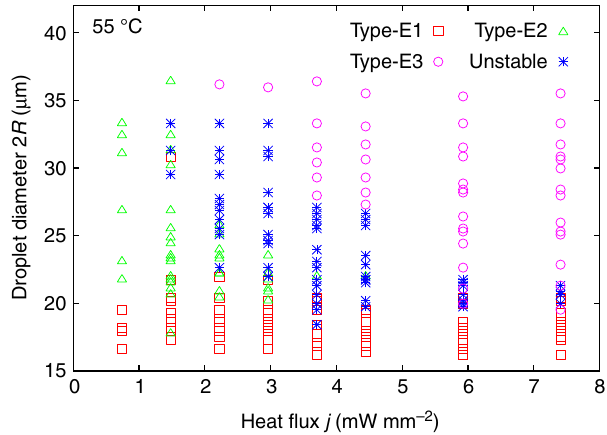
Fig. 6 State diagram of Type-E under the temperature gradient. The droplet sub-types are plotted in the plane of ( j -2 R ). The chiral content was 2.0 wt %. In the small j regions, only Type-E1 (squares) and Type-E2 (triangles) appear and show HIR without texture change (Video 4a in Supplementary Materials). However, by increasing j , Type-E2 is destabilised and transformed into Type-E3 (circles) (Supplementary Movie 8). In the region between Type-E1/E2 and Type-E3, a chaotic turbulent texture was continually observed (unstable state, CFM images for the Type-A droplet, which clearly show the radial director distribution of Type-A (Figs. 1o and 8a) 17 . This arrangement is reasonable in the present case because the inter- face between the LC and the oligomeric solvent has a home- otropic anchoring property 20 . Note that the side-view cross- sectional CFM image suggests a spherical-cap shape, which